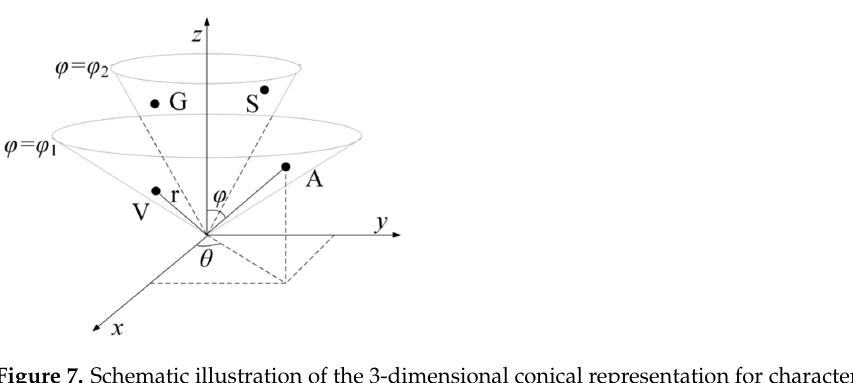
Figure 7. Schematic illustration of the 3-dimensional conical representation for characterizing amino acid residues. A, V, G, and S are the first two amino acids in the Non-polar residue group and Polar residue group. ϕ 1 and ϕ 2 represent the conical surface, which is formed by projection of amino acids in the corresponding group.